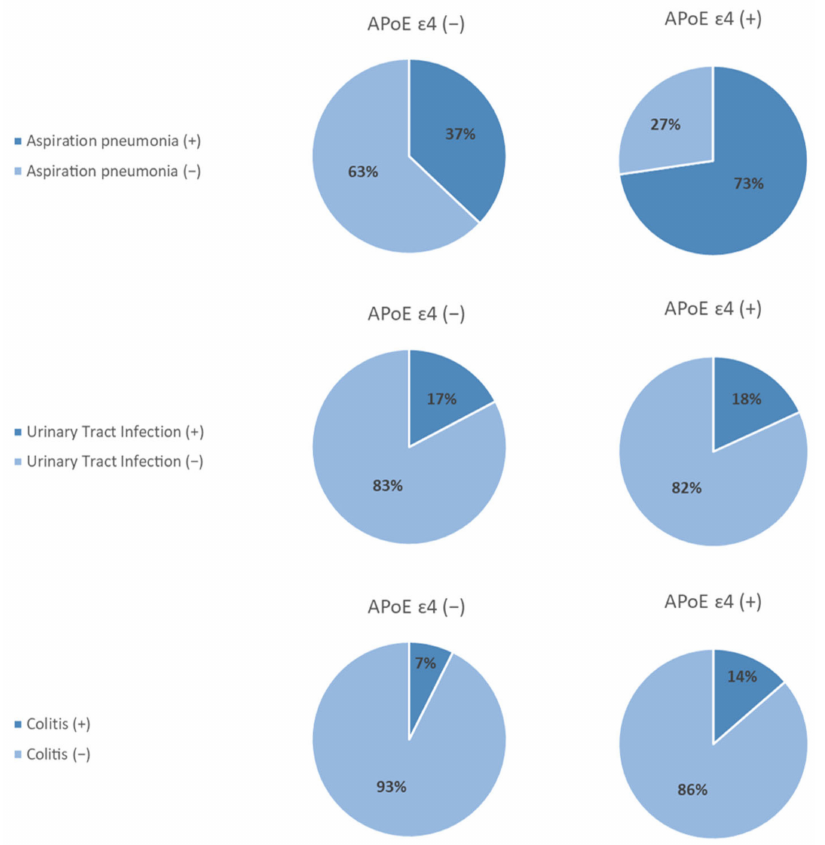
Figure 1. Association of infection and APOE genotypes in the young age group. The incidence of post-stroke aspiration pneumonia was significantly higher in those with APOE (cid:101) 4 ( p = 0.003). The incidence of urinary tract infections ( p = 0.922) and colitis ( p = 0.359) did not differ according to APOE